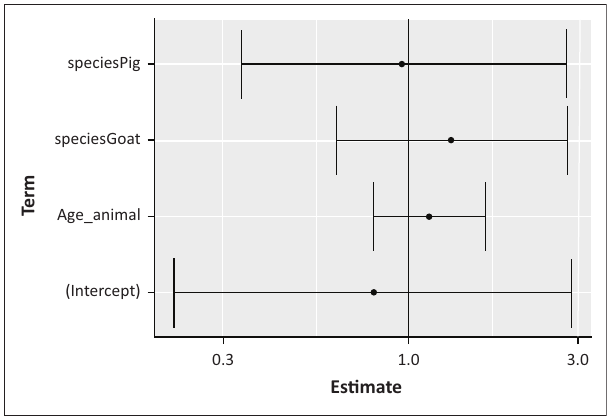
FIGURE 3: Multivariate analysis of laboratory results according to animal TABLE 3: Microscopy results of the different suspected carcasses (sheep, goats and pigs). Animal species